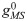
STDP changes the relation between the time delay τ and the synaptic weights.STDP promotes zero-lag synchronization (τ ≈ 0): (a)-(c) τ as a function of the initial excitatory weights gMS0 with and without STDP (represented by circles and squares, respectively). (d)-(f) τ as a function of the inhibitory weights g
IS with and without STDP. (g)-(h) τ (color coded) in the (g
IS, gMS0) parameter space without plasticity (g) and with STDP (h). The near-zero-lag regime is represented by the grey regions, AS (τ < 0) by the red regions and DS (τ > 0) by the blue ones. In the presence of STDP, τ is determined by the local amount of inhibition g
IS.